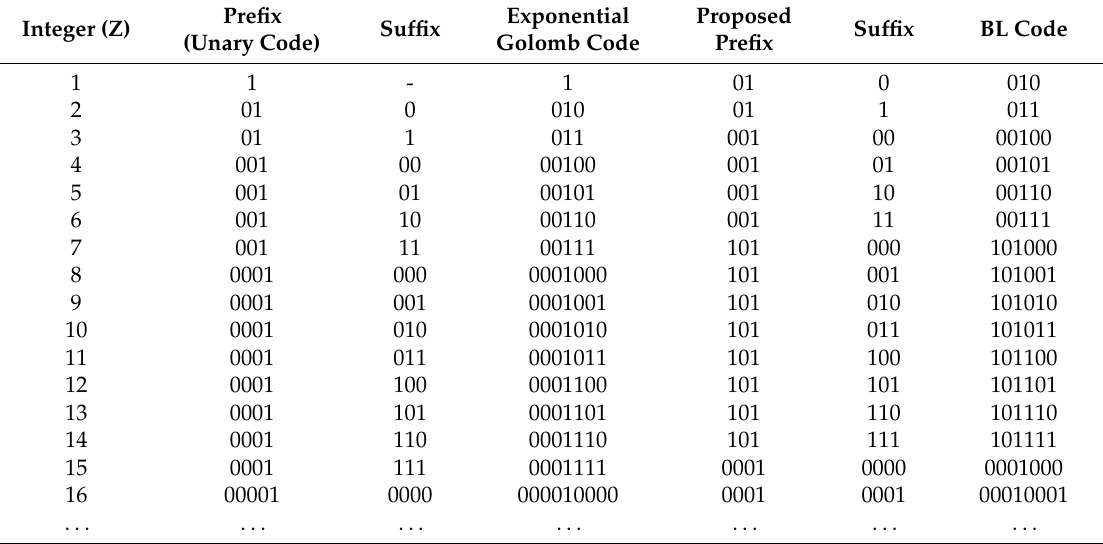
Table 2. Encoded codes using the conventional golomb and BL